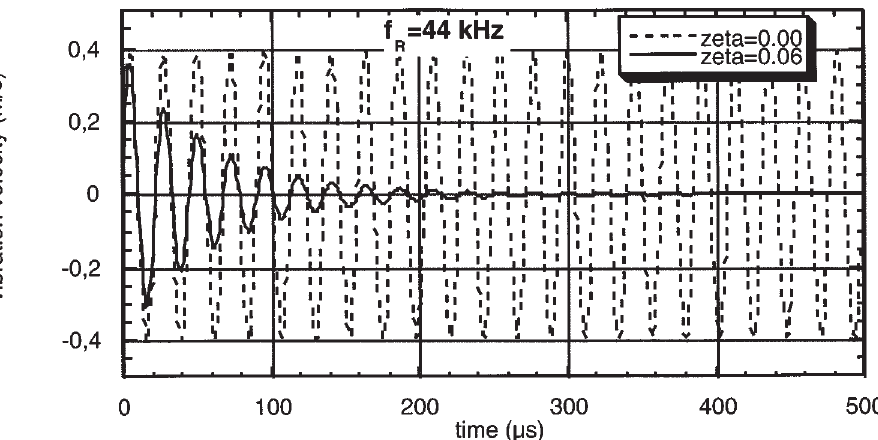
Fig. 12. Calculated displacements velocities excited by a pressure pulse due to a detonation. The equations allow for a vibration mode with rotational symmetry. Parameters: E = 2 : 0 (cid:2) 10 11 N/m 2 , (cid:26) = 7900 kg/m 3 , R a = 24 mm, R i = 15 mm, p max = 700 bar, f R = 44 kHz.